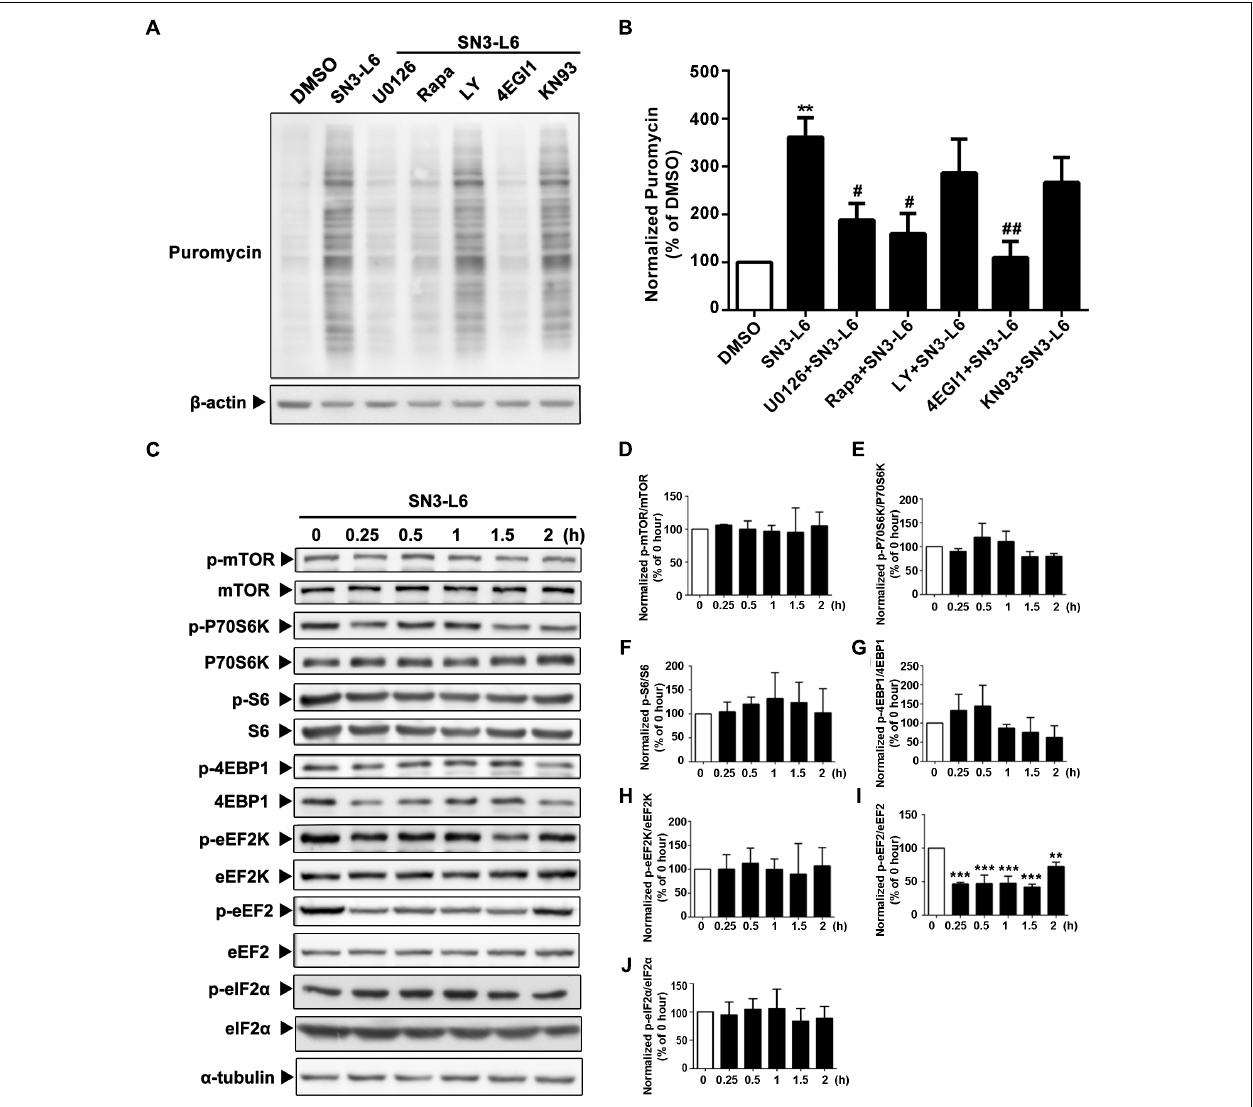
FIGURE 4 | Translation activated by SN3-L6 requires MEK and mTOR activity and is cap-dependent. (A) Neuro-2a cells were treated with SN3-L6 (25 µ M) together with MEK inhibitor (U0126; 10 µ M), mTORC1 inhibitor [Rapamycin (Rapa); 10 µ M], PI3K inhibitor (LY294002; LY; 10 µ M), cap-dependent translation initiation inhibitor (4EGI1; 50 µ M) or CaMKII inhibitor (KN93; 0.5 µ M) for 2 h. Nascent polypeptides were examined by puromycin incorporation. (B) Quantification of puromycin incorporation levels. ∗∗ P < 0.01, SN3-L6 vs. DMSO; # P < 0.05, ## P < 0.01, co-treatment vs. SN3-L6. (C) SN3-L6 was added in Neuro-2a cells for indicated time points (0–120 min). Cells lysates were subjected to Western blot analysis for the phosphorylated- and total-forms of different signaling molecules. (D–J) Quantification of the phosphorylation levels of different molecules. ∗∗ P < 0.01, ∗∗∗ P < 0.001, SN3-L6 treatment vs. no treatment (0 h). All data shown in